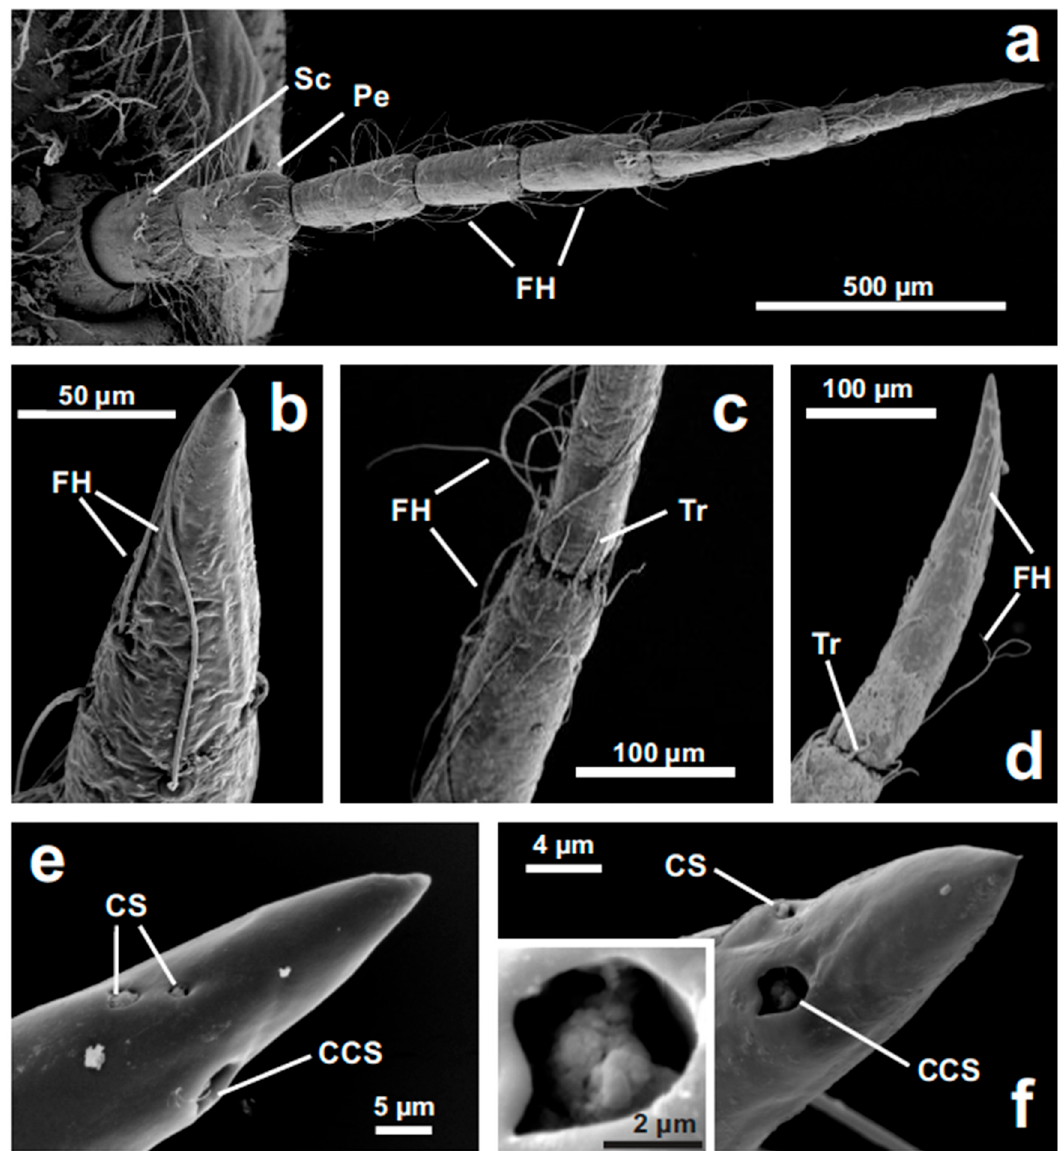
Figure 1 . Nymphal (from F-5 to F-0 instars) antenna of Libellula depressa under SEM. ( a ) The antenna is composed of scape (Sc), pedicel (Pe) and five flagellar segments, bearing numerous filiform hairs (FH) (F3). ( b ) Filiform hairs (FH) on the last flagellar segment (F3). ( c ) Trichoid sensilla (Tr) in the distal portion of each flagellar segment contact the following segment (F3); FH, filiform hairs. ( d ) Filiform hairs (FH) and trichoid sensilla (Tr) on the distal portion of the antenna (F5). ( e , f ) Detail of the composed coeloconic sensillum (CCS) and the paired single coeloconic sensilla (CS) in F4 ( e ) and F5 ( f ) nymphs. The irregular structure of the composed coeloconic sensillum is shown in the inset ( f ).